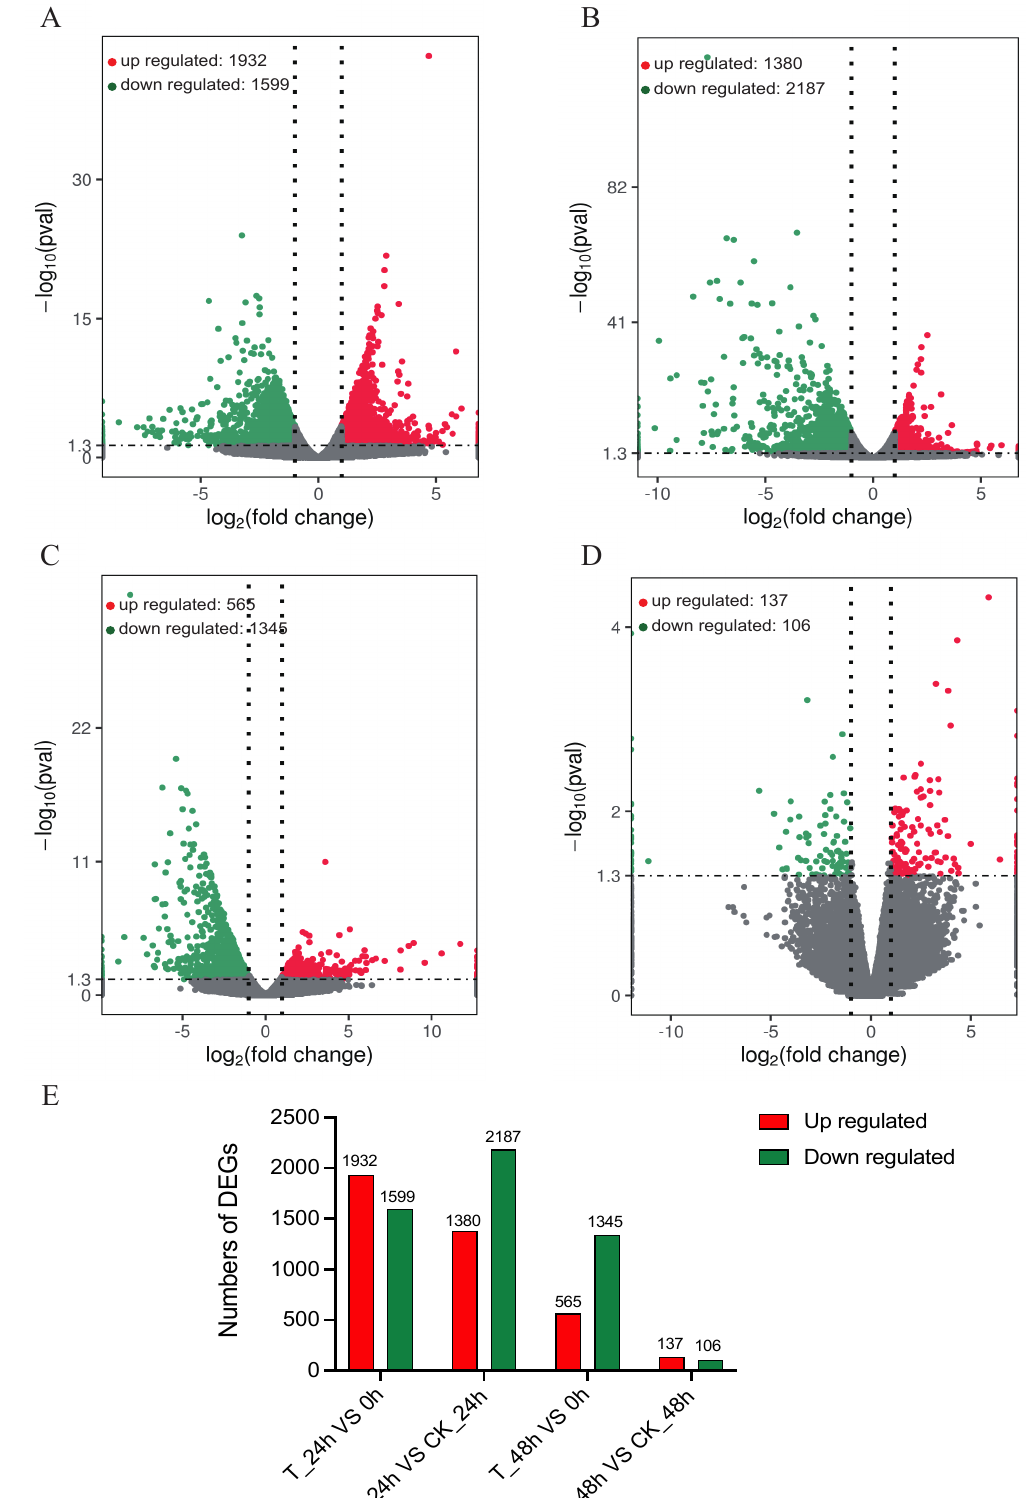
Figure 2. The volcano plot and numbers of differentially expressed genes (DEGs) of S. furcifera identified after M. anisopliae inoculation. ( A ) The volcano plot of DEGs at 24 h post inoculation vs. 0 h; ( B ) the volcano plot of DEGs at 24 h post inoculation vs. 24 h control; ( C ) the volcano plot of DEGs at 48 h post inoculation vs. 0 h; ( D ) the volcano plot of DEGs at 48 h post inoculation vs. 48 h control; and ( E ) the number of S. furcifera DEGs during M. anisopliae infection from 0 to 48